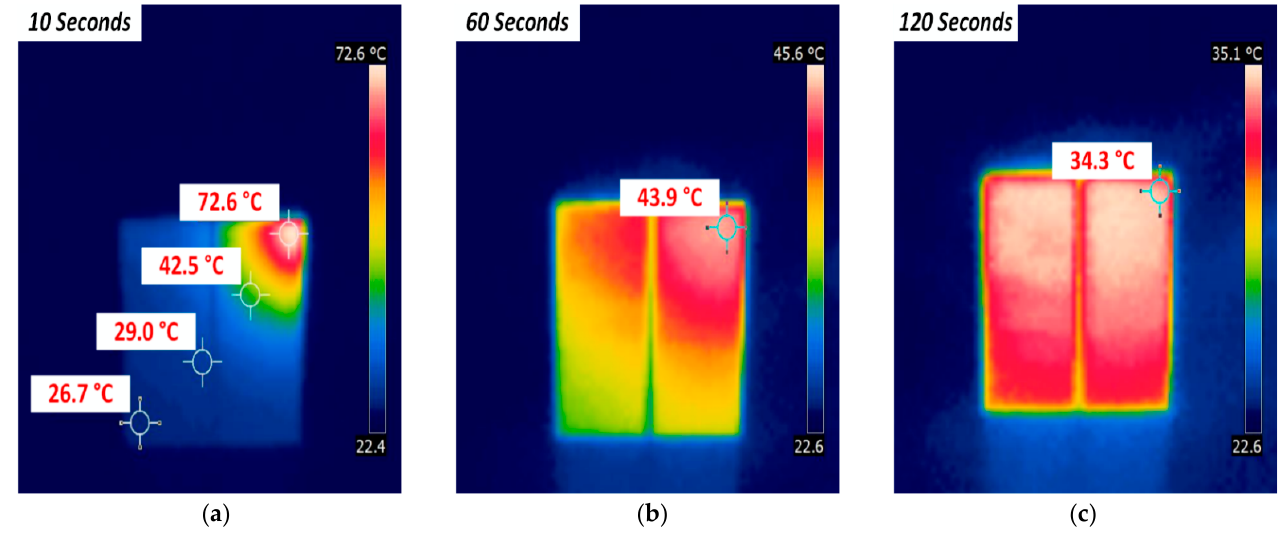
Figure 7. Heatmap distribution of a cracked solar cell sample, operating under standard test condi- tions. Images were captured using a FLIR thermal camera: ( a ) After 10 s; ( b ) after 60 s; ( c ) after 120 s—This level of temperature remains steady [51].